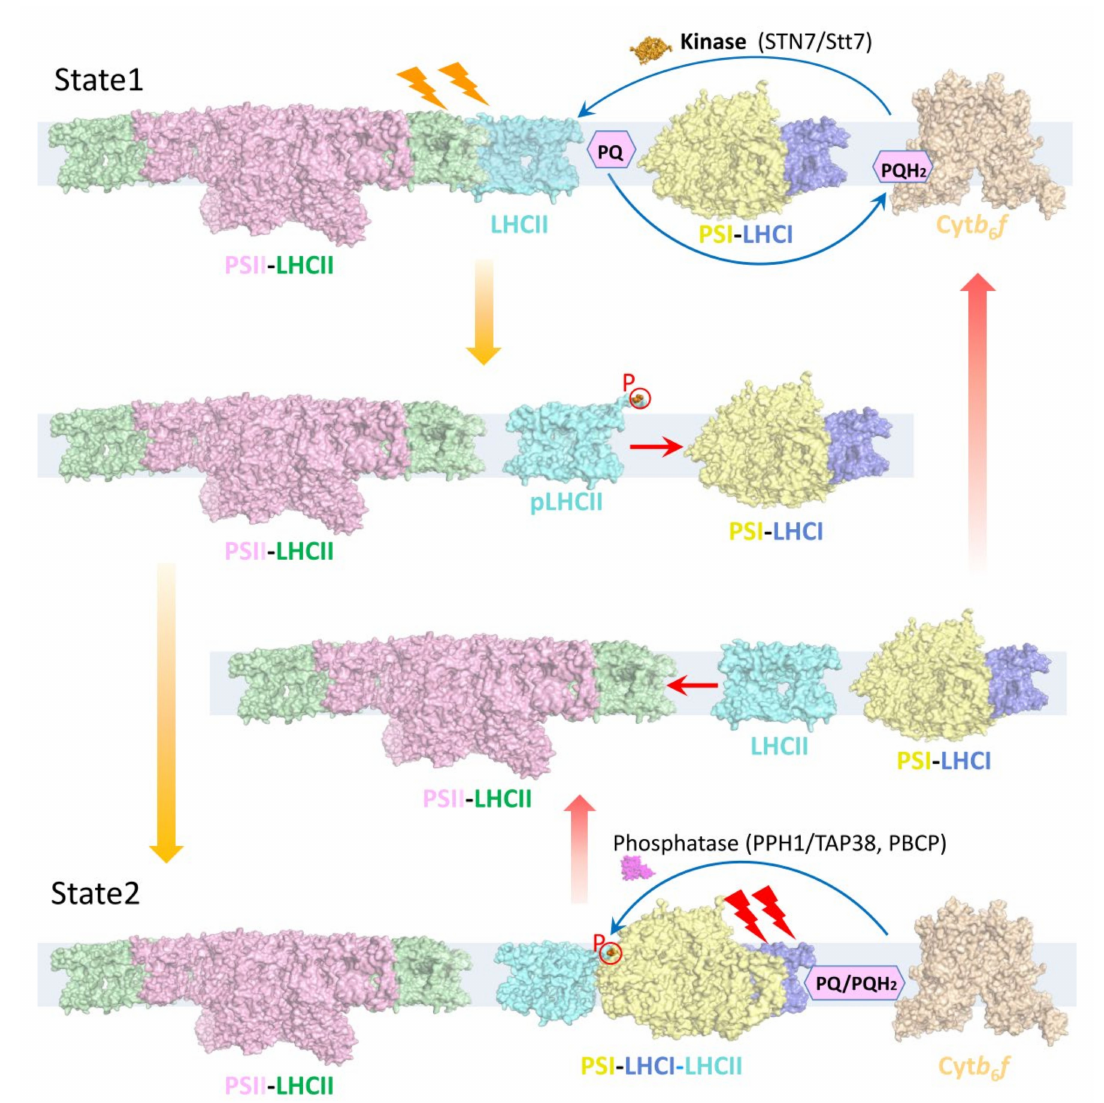
Figure 1. Model of state transitions in the thylakoid membrane. During state transitions, LHCII is reversibly phosphorylated; the dephosphorylated and phosphorylated forms bind to PSII (state 1) and PSI (state 2), respectively. When PSII is preferentially excited, PQ molecules are reduced to PQH 2 . Docking of PQH 2 to cytochrome b 6 f (Cyt b 6 f ) leads to the activation of a chloroplast kinase (STN7/Stt7), which is required for the phosphorylation of LHCIIs, causing phosphorylated LHCIIs (pLHCII, cyan) to dissociate from PSII and associate with PSI-LHCI, forming the PSI–LHCI–LHCII supercomplex (state 2). When PSI is preferentially excited, PQH 2 is oxidized to PQ, and phosphatases (PPH1/TAP38 in plants and PPH1 and PBCP in C. reinhardtii ) catalyze the dephosphorylation of mobile LHCIIs and their re-association with PSII (state 1). Coordinates (PDB codes) used for the structural representation are 5XNM (PSII–LHCII), 4XK8 (PSI-LHCI), 5ZJI (PSI–LHCI–LHCII and pLHCII), 1RWT (LHCII), 6RQF (Cyt b 6 f ), 4IX3 (Stt7), 4YZG